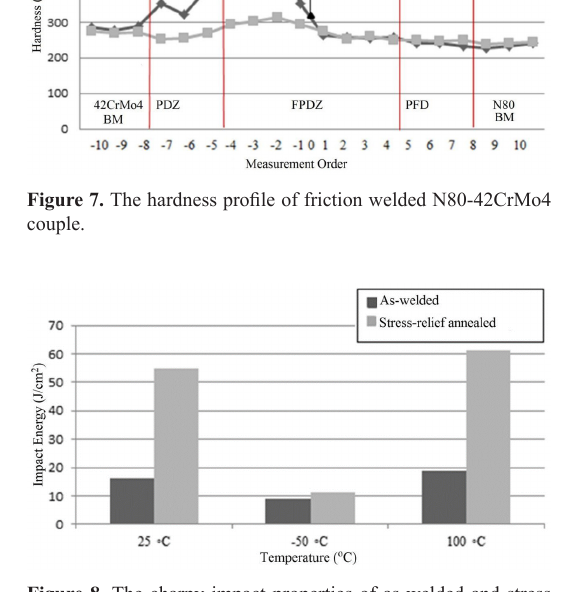
Figure 6. The fractured surface of N80-42CrMo4 tensile test sample; a and b) As-welded, c and d) Stress relief annealed.